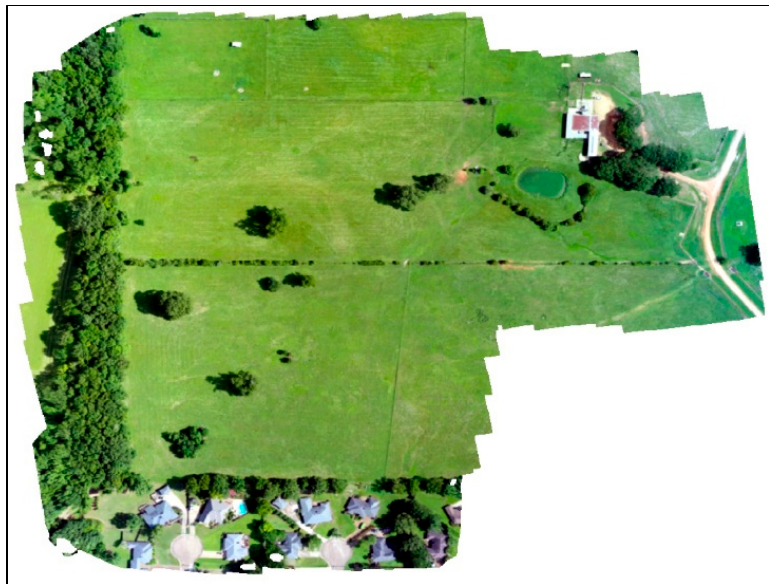
Figure 5. Mosaic created from 119 images of the MSU South Farm.